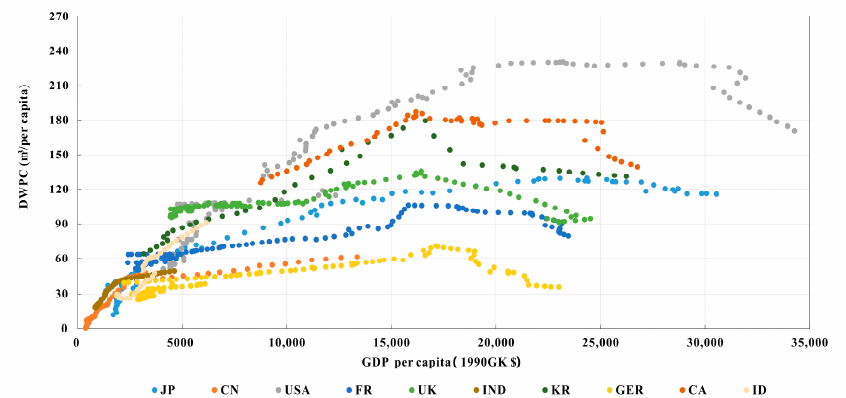
Figure 3. Relationship between GDP per capita and DWPC for 10 typical countries.